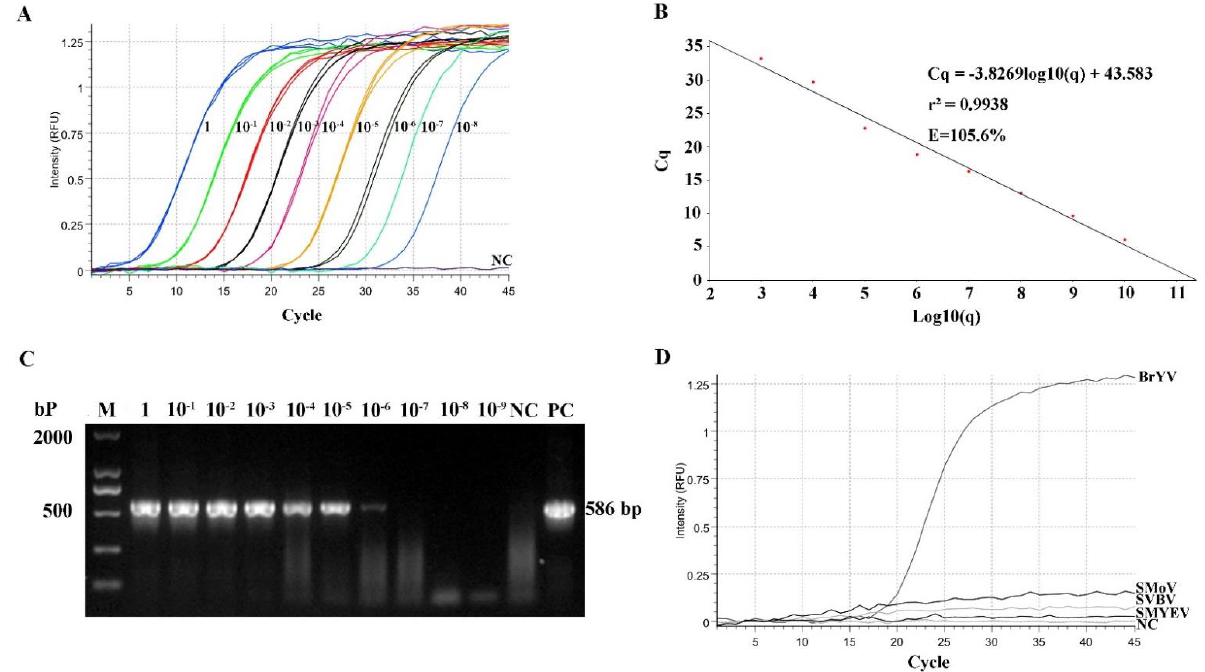
Figure 5. RT-qPCR detection of BrYV. ( A ) The sensitivity of the RT-qPCR. Ten-fold dilutions of the standard plasmid of BrYV were used as templates, starting from 1 μg/μL (1). RNase-free H 2 O was used as a negative control (NC). ( B ) Standard curves obtained for the BrYV quantification. The horizontal axis reports a series of ten-fold dilutions of the recombinant plasmid, while the vertical axis shows the Cq values obtained in the reactions. The R 2 was used to evaluate the accuracy of the results obtained in triplicate assays (the closer it is to 1, the better). RT-qPCR was performed in three replicates. ( C ) Comparison of the sensitivity of RT-qPCR and RT-PCR. Ten-fold dilutions of the recombinant plasmid of BrYV were used as templates, starting from 1 µ g/ µ L. RNase-free H 2 O was used as a negative control (NC). The prepared templates were detected simultaneously by RT-qPCR ( A ) and RT-PCR ( C ). ( D ) Evaluation of the specificity of RT-qPCR. Table 2. Repeatability analysis of the established TaqMan RT-qPCR method for BrYV detection. Cq Value